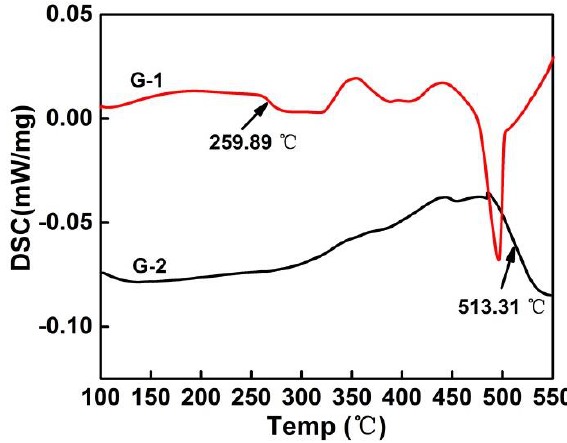
Figure 6. DSC curve of the as-prepared glass frit.